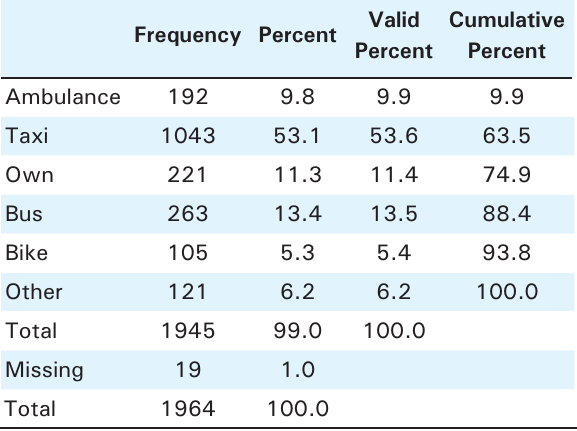
Table 2. PH ED patients by mode of transport